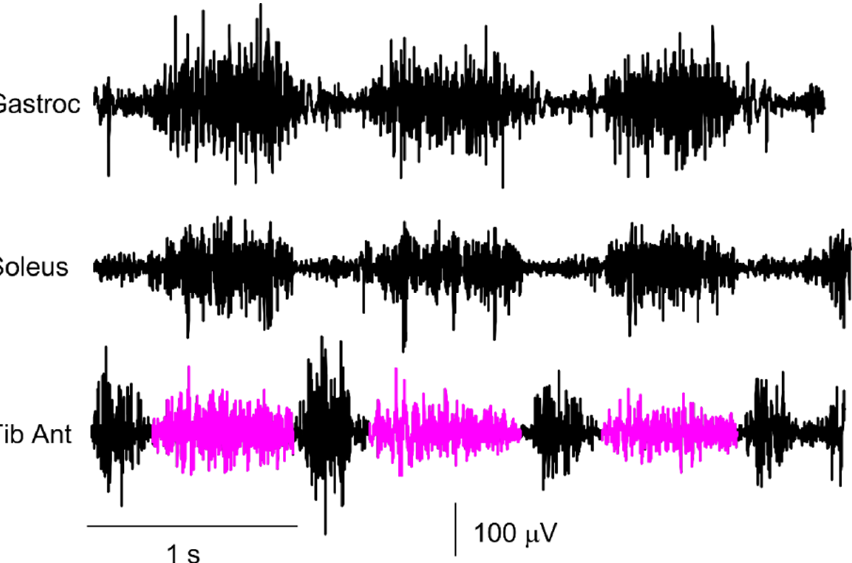
Figure 26. Example of sEMG signals acquired during gait analysis of the leg of a healthy 10-year-old boy by means of pairs of circular electrodes: diameter of the conductive region = 10 mm; detection area = 78.5 mm 2 ; center to center distance = 20 mm. Crosstalk on the tibialis anterior from the plantar flexors is outlined in purple. Reproduced from Ref. [72].